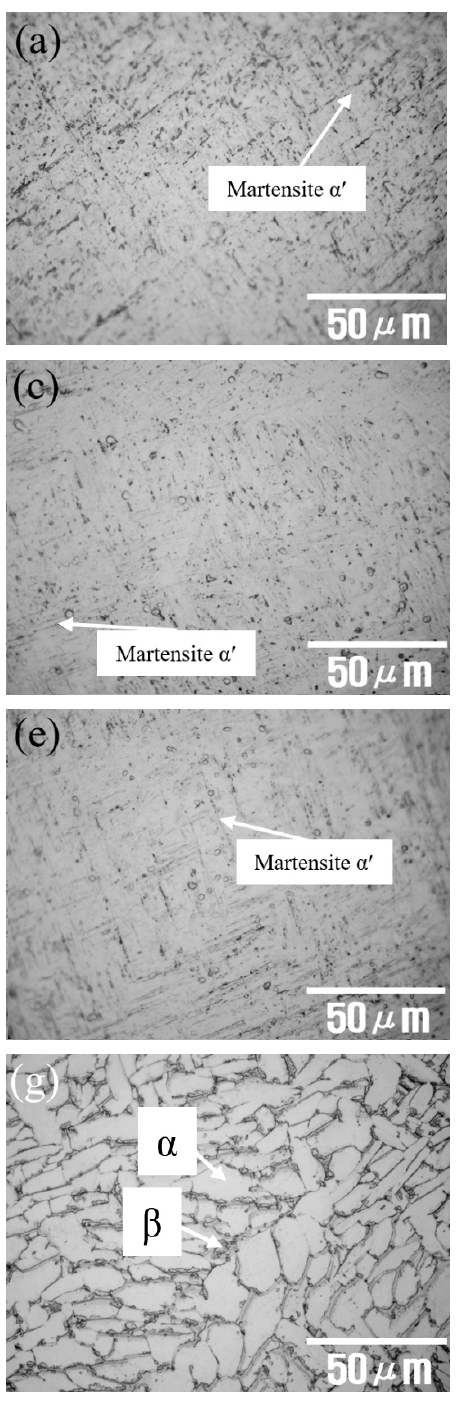
Figure 2. Optical micrographs of the AM Ti–6Al–4V alloys: ( a ) as-received sample and heat-treated samples: ( b ) 650HT, ( c ) 650WQ, ( d ) 750HT, ( e ) 750WQ, ( f ) 850HT, and ( g ) 1000HT (HT: furnace cooling; WQ: water quenching).